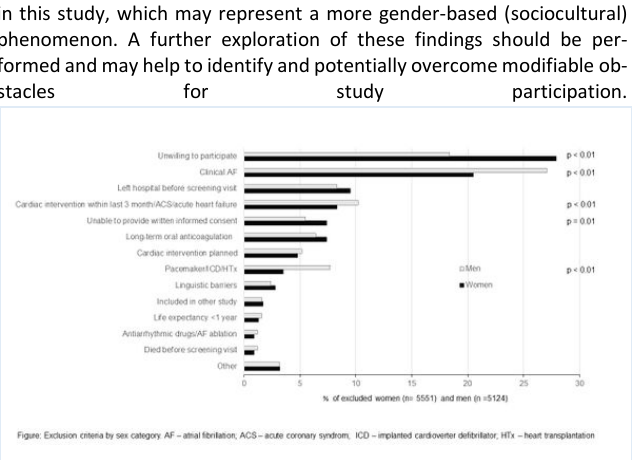
Algorithm for real-time analysis of